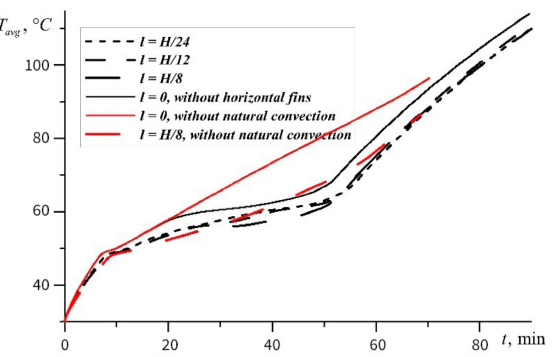
Figure 5. The rise in the average source temperature for the Ostrogradsky number Os =